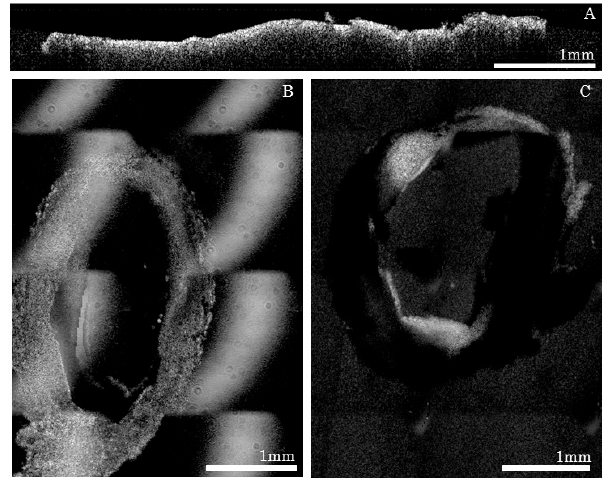
Figure 5. Sources of imaging artifacts and their effects during acquisitions: ( A ) Unevenly cut slice; ( B ) Artifact caused by the glass when the reference arm was not properly placed; ( C ) Slice that was imaged while not placed at the focal point of the lens.